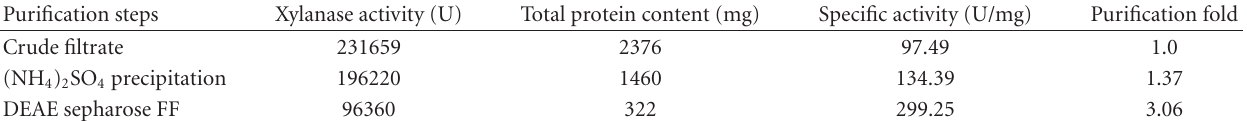
Table 2: Purification steps of xylanase enzyme isolated from Bacillus arseniciselenatis DSM 15340 when grown on wheat bran.